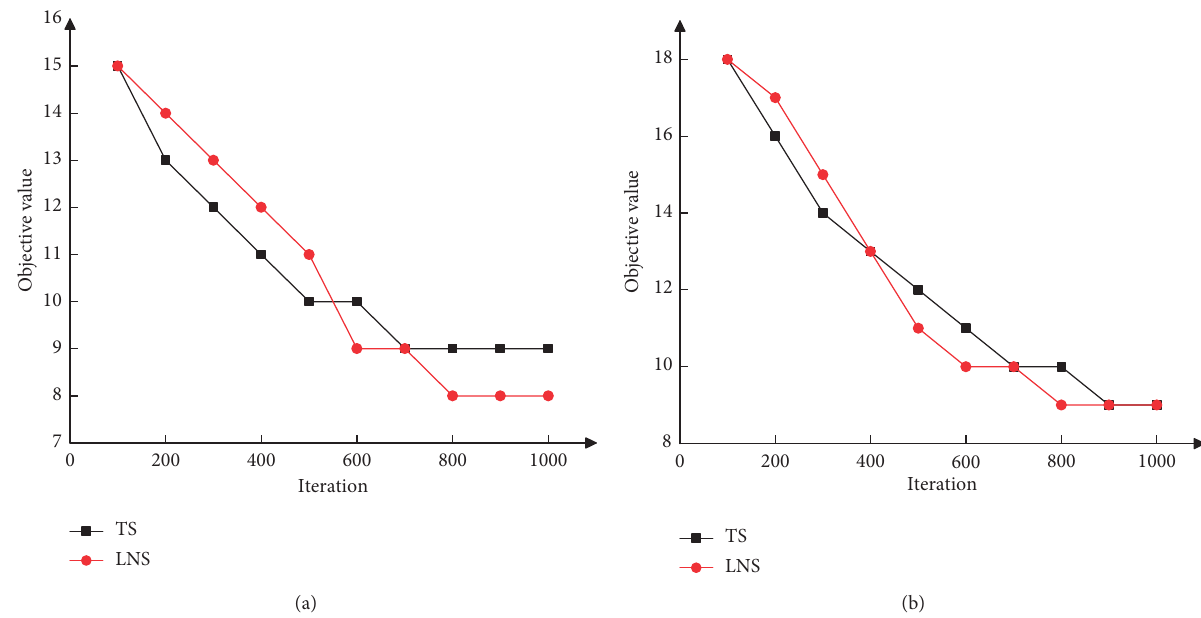
Figure 3: The convergence processes for instances. (a) Instance b8-64 (b) Instance